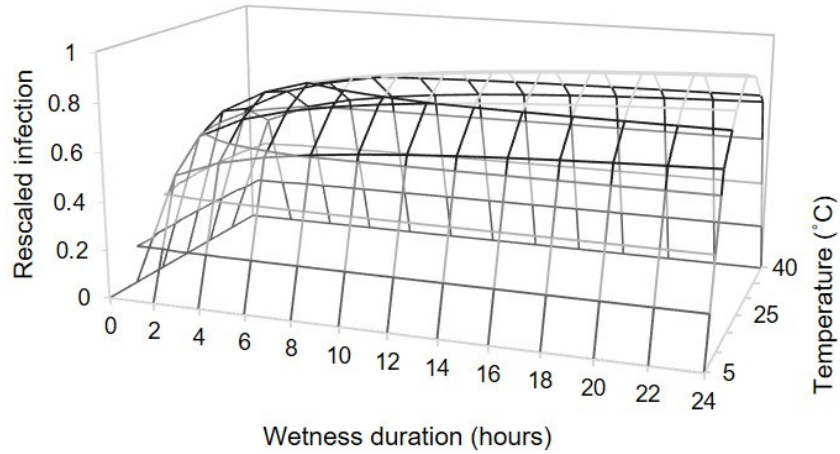
Figure 3. Effects of temperature and wetness duration on the rescaled infection severity in grapevine berries inoculated with conidia of Coniella diplodiella , as estimated by Equation (2) and with data from experiment 1. After uninjured berries, injured berries, or pedicels attached to uninjured berries were inoculated, the berries were kept at 5 wetness duration periods (1–24 h) and at 6 temperatures (10–35 ◦ C). For fitting purposes, AUDPC data were rescaled on a 0–1 scale by dividing the original AUDPC values by the maximal value for each infection pathway (uninjured, injured, and pedicels).